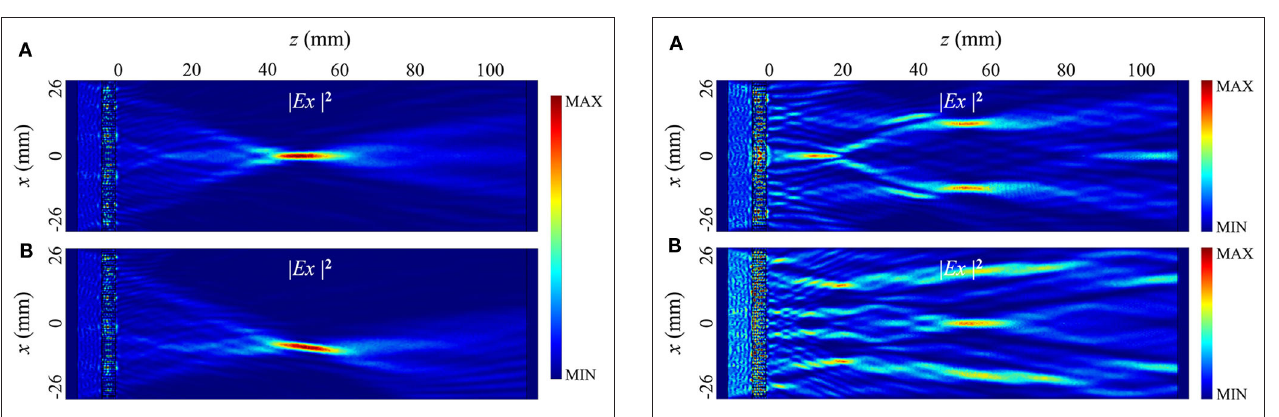
FIGURE 2 | Simulated intensity distributions of (A) on-axis and (B) off-axis focusings with a focal length L = 5cm.